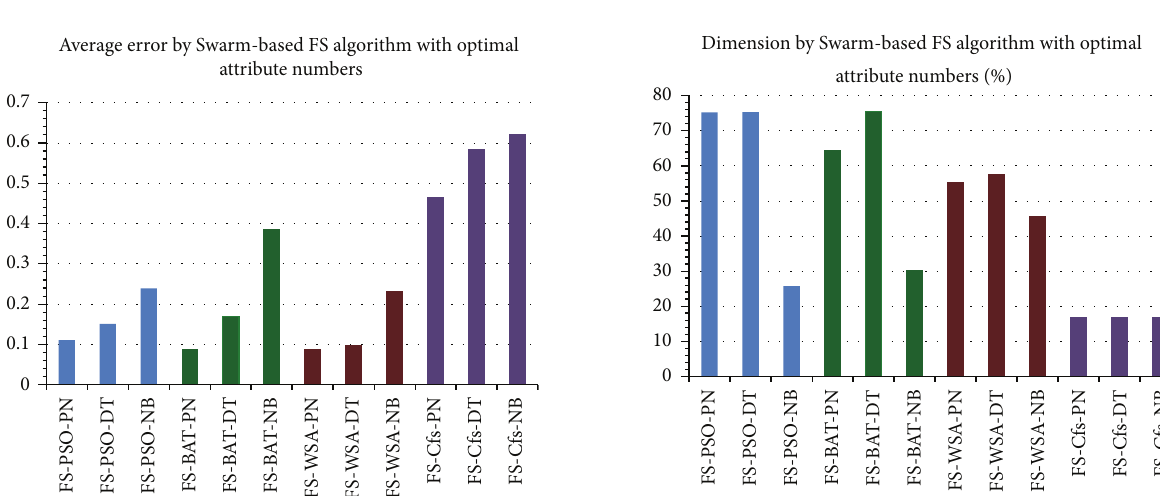
Figure 13: Comparison of different Swarm-based FS algorithms with optimal features in average error.